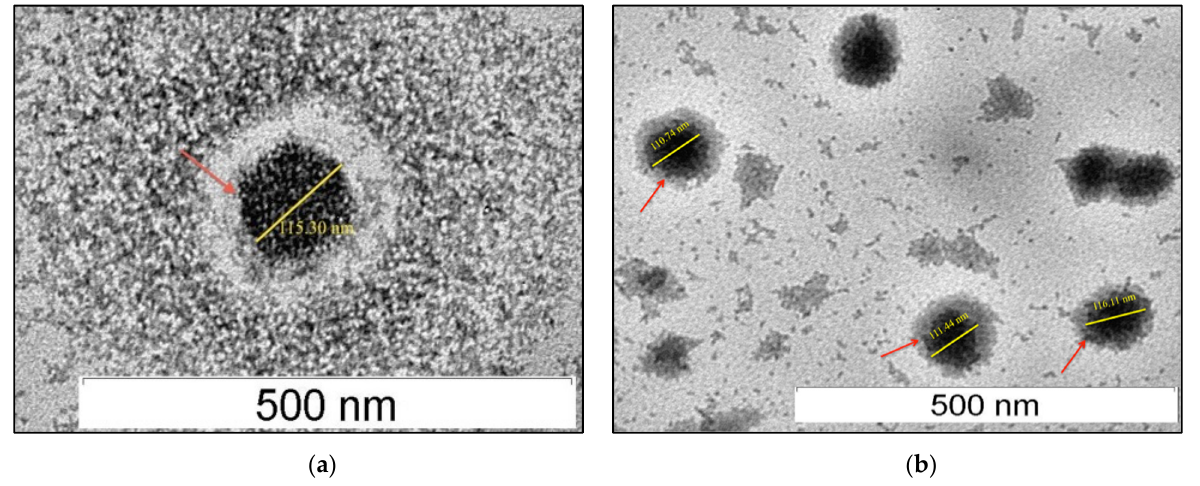
Figure 2. Transmission electron micrograph of drug-free SLN ( a ) and acyclovir-loaded SLN ( b ) at 60000× magnification.